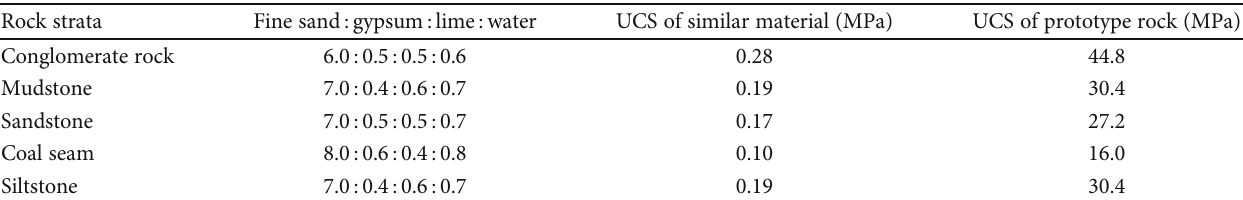
Figure 2: Physical model constructed on the GDSTM and general experimental monitoring plan. Table 2: Parameters of the similar